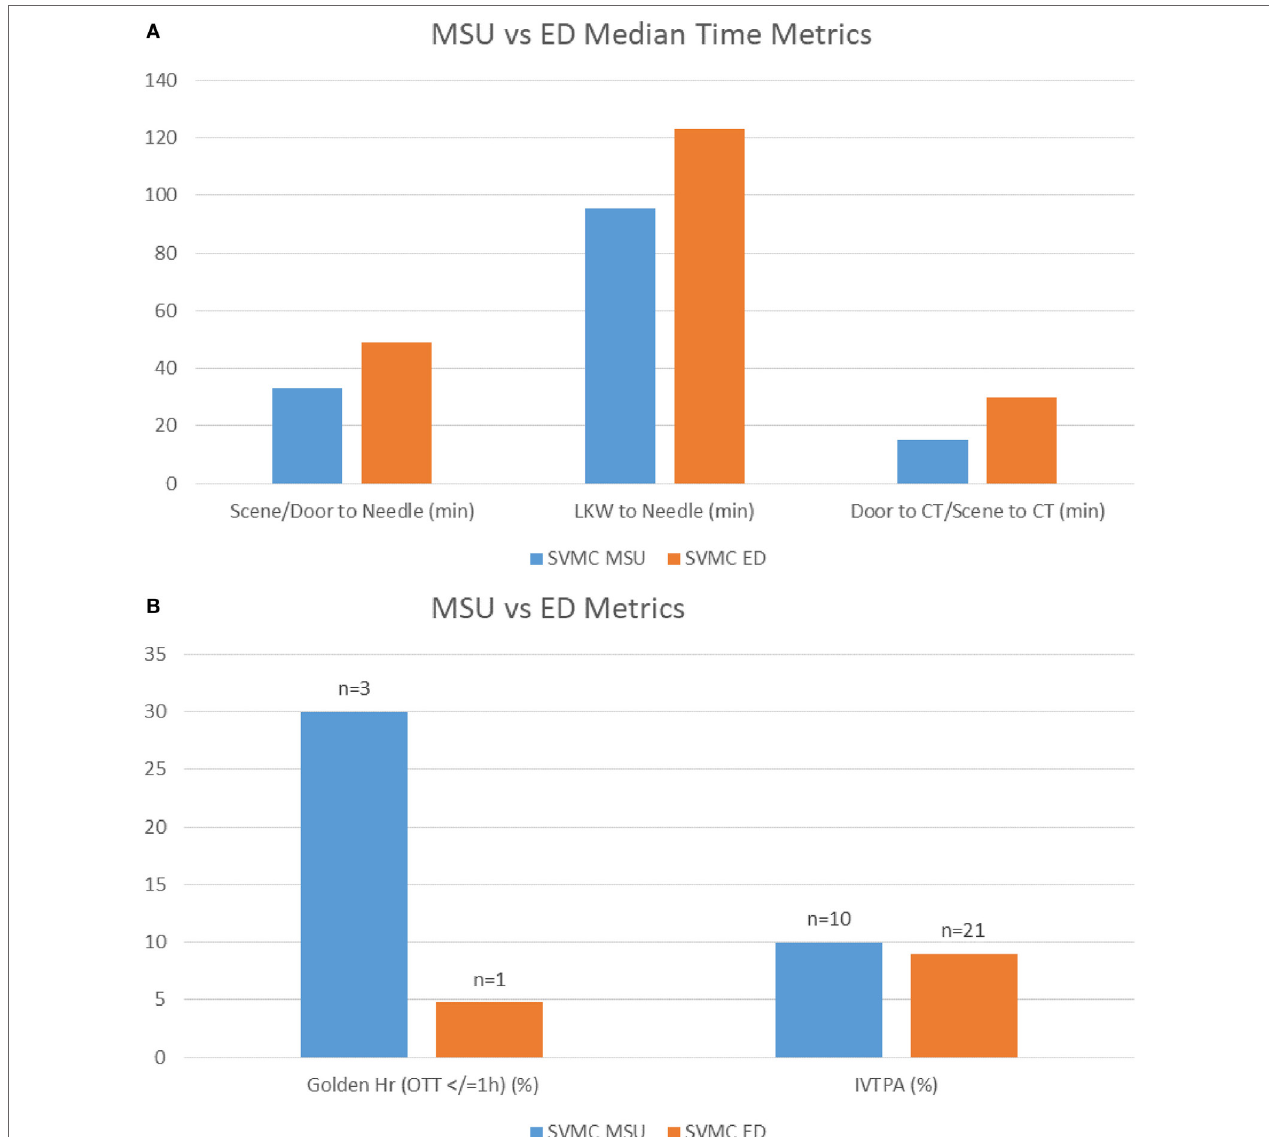
FigUre 3 | (a) Comparison of Mercy Health Mobile Stroke Unit (MSU) to ED patients demonstrating the difference in minutes of patient triage and stroke metrics. (B) Comparison of Mercy Health MSU to ED with percent of patients treated in the golden hour under 60 min and percent treated of those activated for stroke